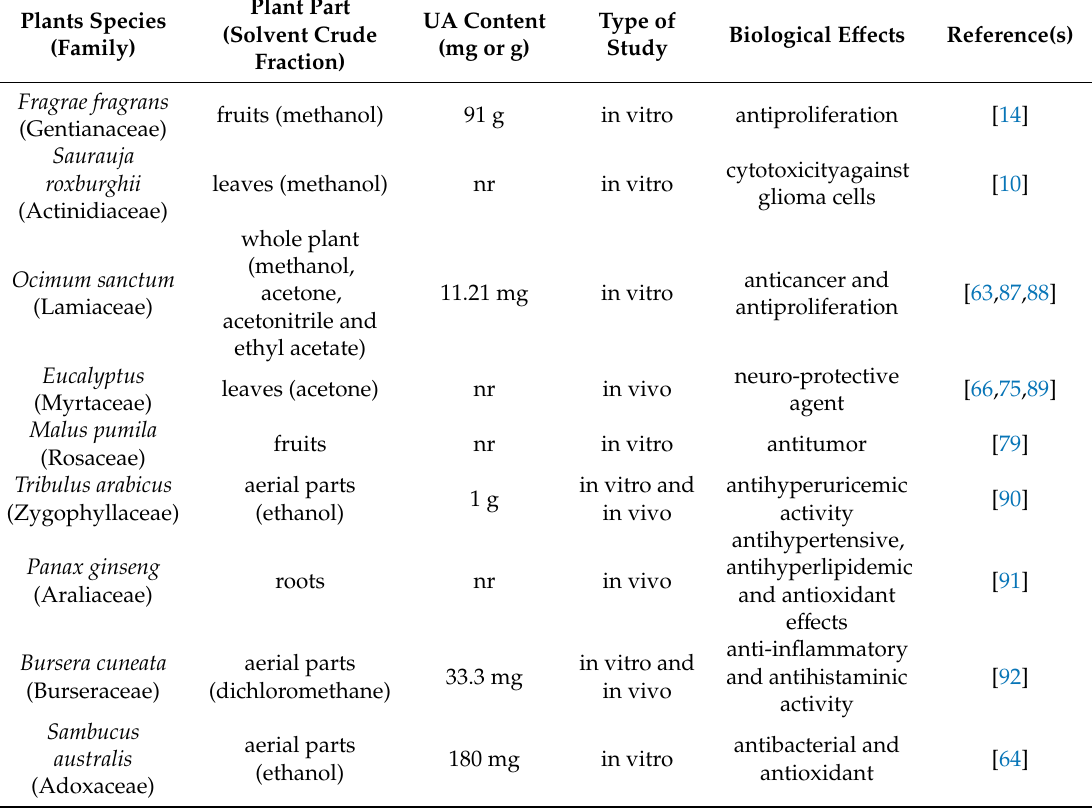
Table 3. Sources of UA with their biological